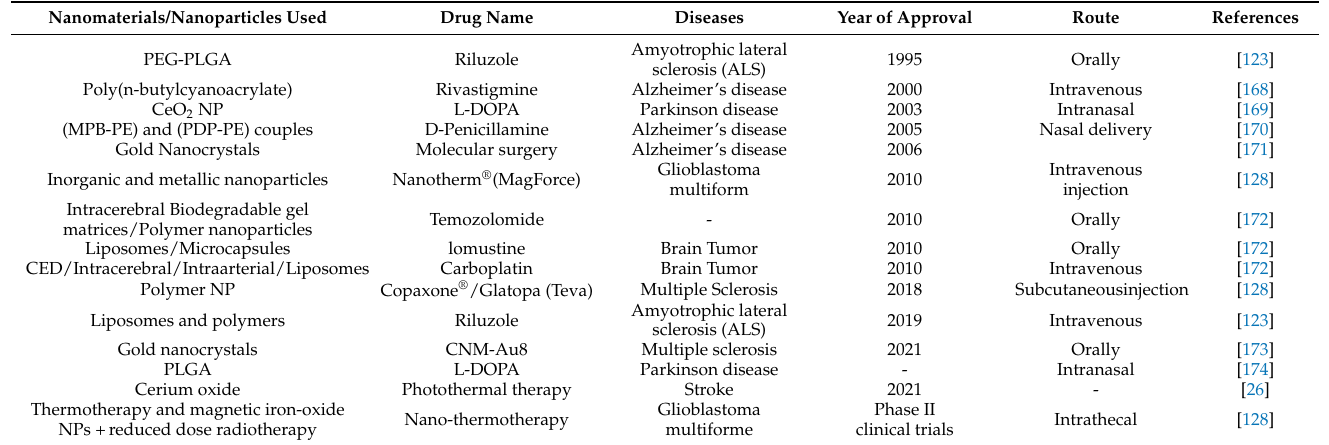
Table 1. Examples of FDA-approved drugs for the treatment of various